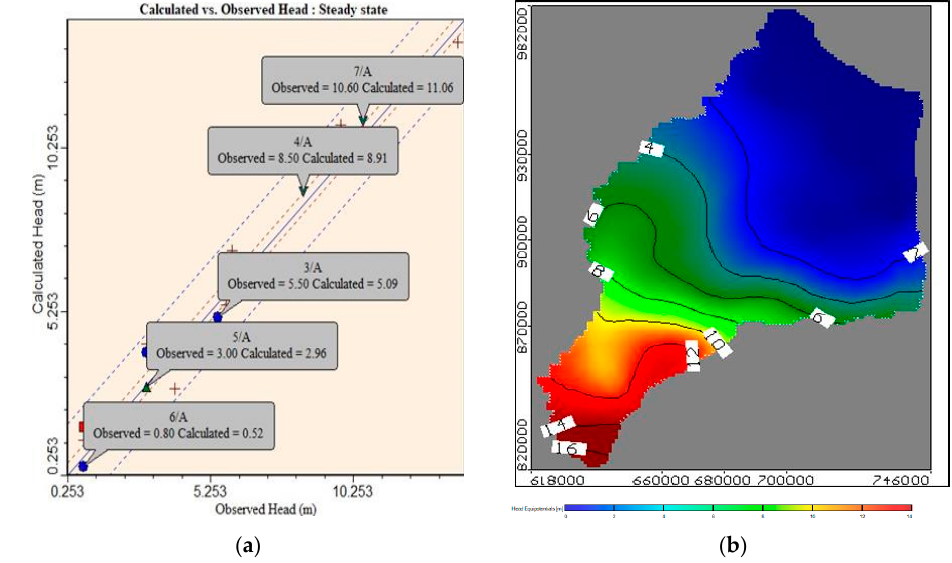
Figure 5. Results of model calibration: ( a ) calculated and observed head and ( b ) areal section of groundwater flow head in the ENDA.